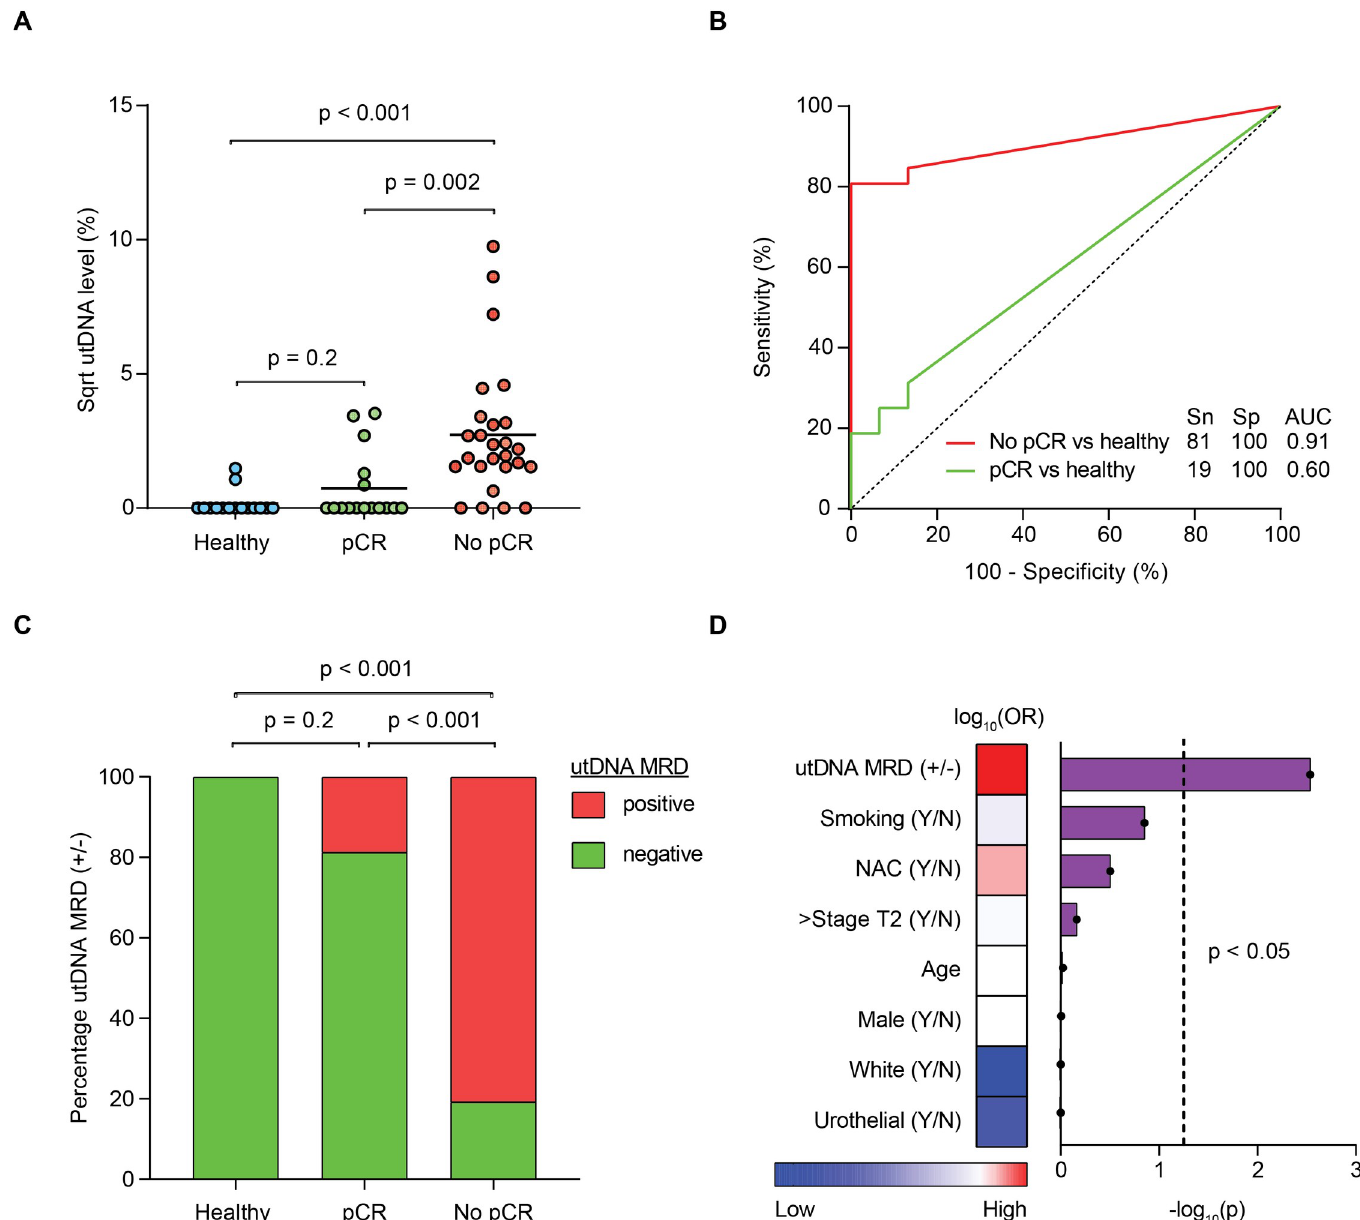
Fig 3. utDNA MRD analysis in patients with localized bladder cancer. (A) Scatter plot of utDNA MRD levels (highest non-silent VAF per patient at preoperative time point) after square root transformation for 3 groups: healthy adults, patients with pCR, and patients with no pCR. The p -values were calculated using Mann–Whitney U test with α of 0.017 after Bonferroni correction. (B) ROC analysis classifying localized bladder cancer patients (either pCR or no pCR) versus healthy adults by utDNA level. AUC and Youden index–optimized sensitivity and specificity values are shown. (C) Stacked bar plots showing the proportions of each group with positive or negative utDNA MRD detection, determined using the optimal utDNA level threshold (VAF: 2.3%) that classified patients with no pCR from healthy adults. The p -values were calculated using Fisher exact test with α of 0.017 after Bonferroni correction. (D) Multivariate logistic regression predicting the absence of pCR. The heatmap shows logarithm of the OR for each variable in the logistic regression. Each bar shows a negative logarithm of the p -value, with the dashed line denoting α of 0.05. AUC, area under the curve; MRD, minimal residual disease; OR, odds ratio; pCR, pathologic complete response; ROC, receiver operating characteristic; Sn, sensitivity; Sp, specificity; Sqrt, square root; utDNA, urine tumor DNA; VAF, variant allele fraction; Y/N, yes/no.